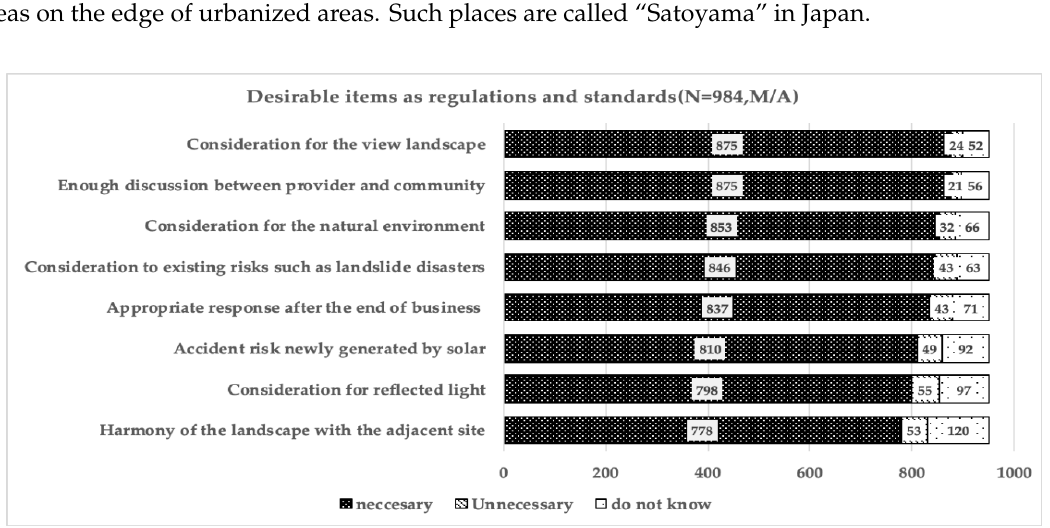
Figure 3. Survey results on the issues recognized by local governments (M/A). Source: Own survey data.